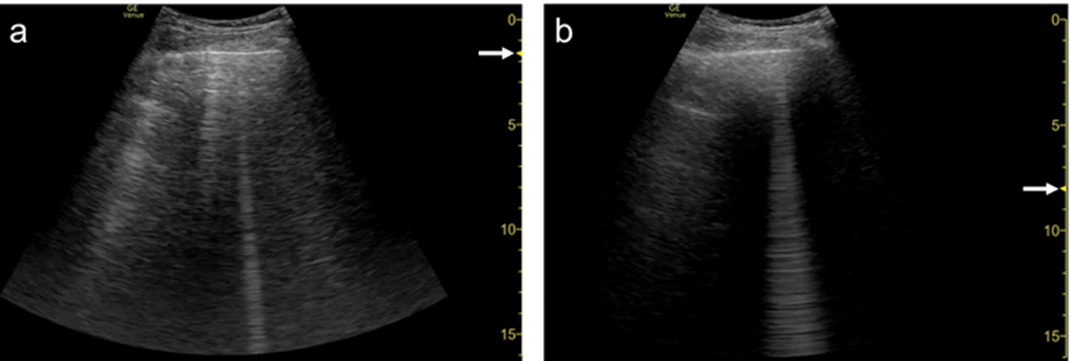
Figure 6. Ultrasound images obtained by Venue scanner (GE Healthcare) with a linear transducer. The B-line becomes wider as the single focal point (arrow) is shifted from the same level as the pleural line ( a ) to a deep level ( b ).